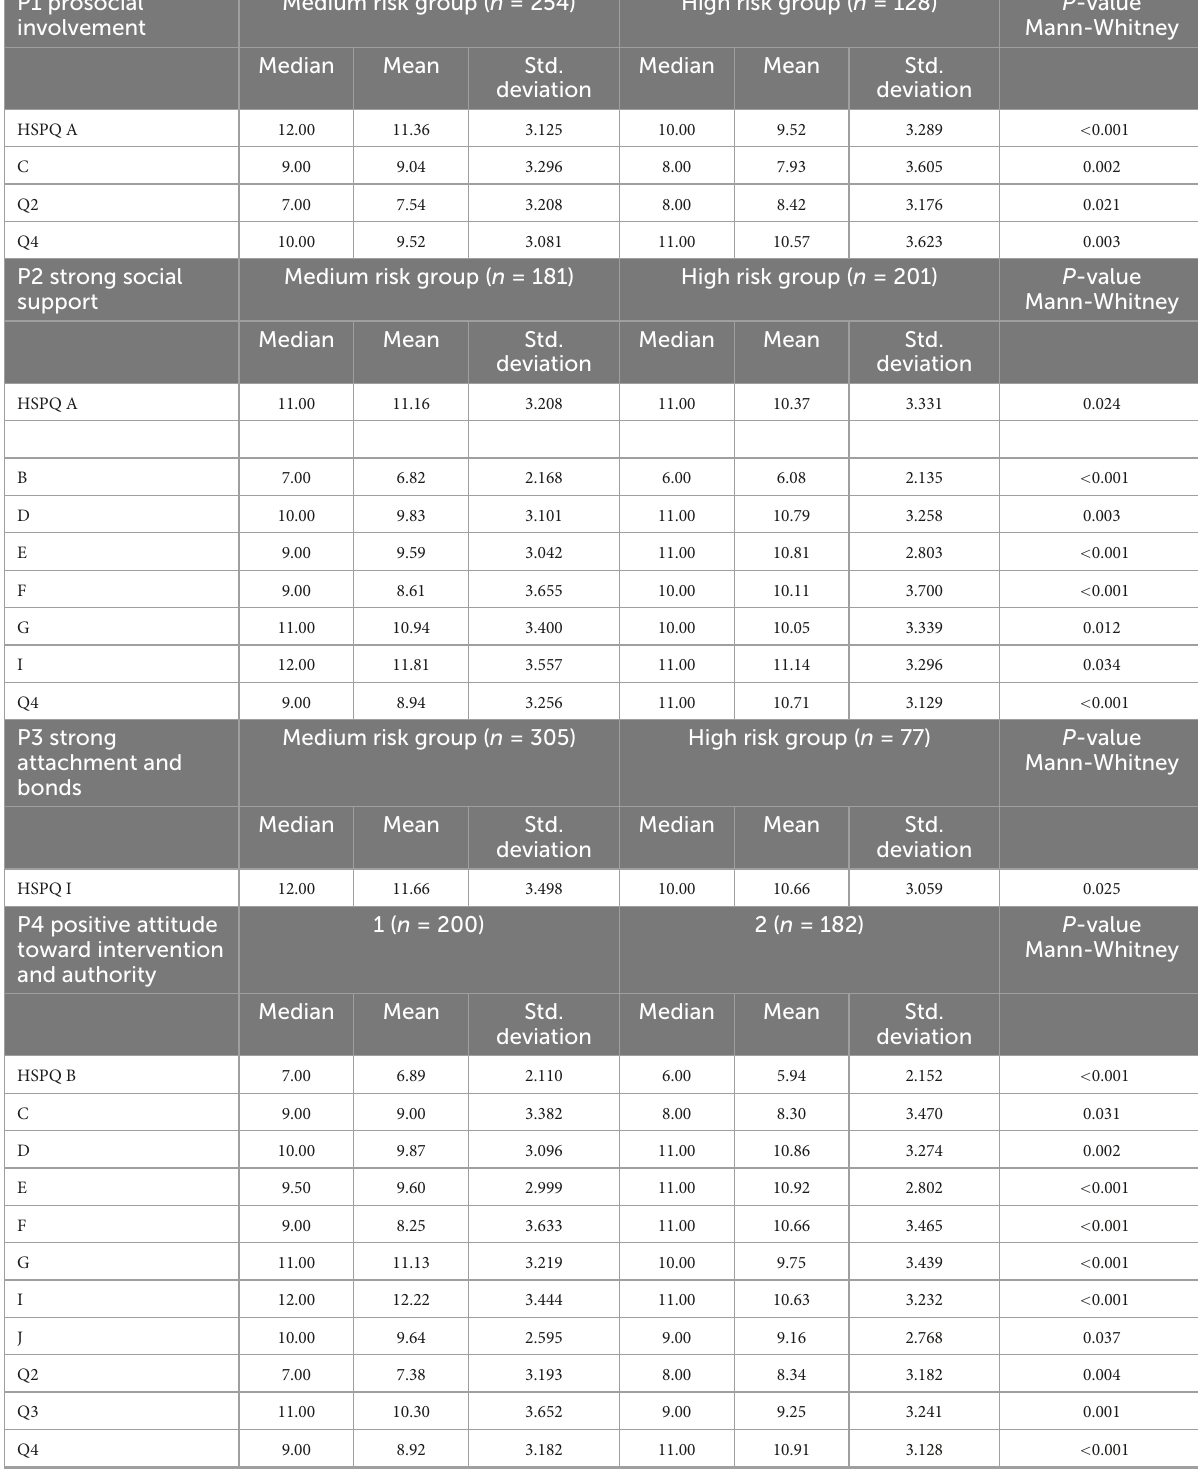
TABLE 5 High school personality questionnaire (HSPQ) personality questionnaire items differences between two groups. P1 prosocial